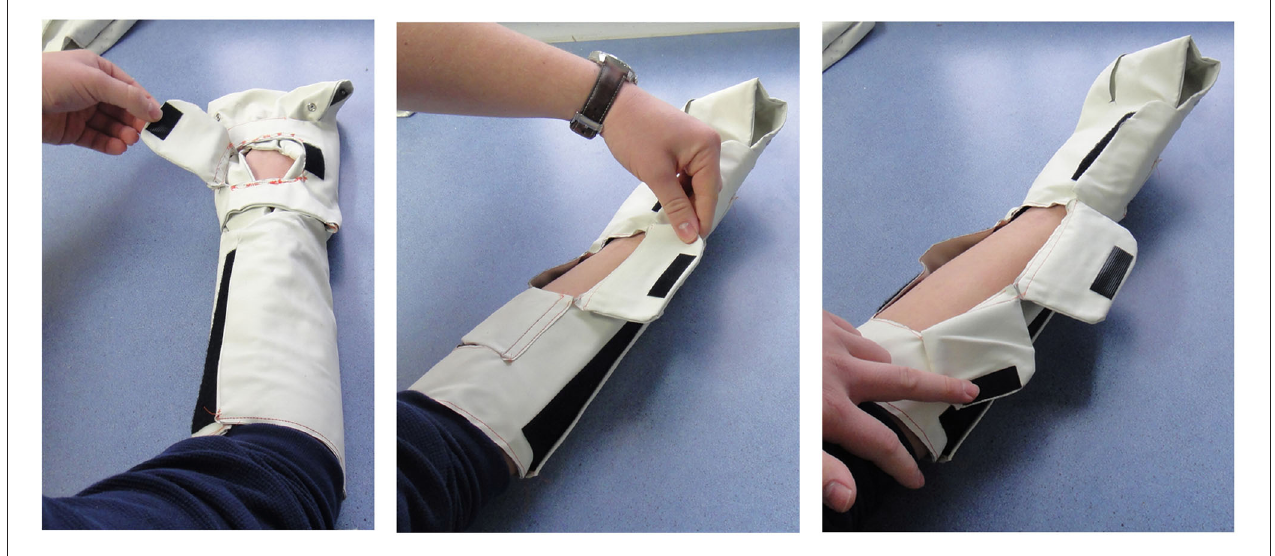
FIGURE 9 | Intravenous cannula site windows in the “Sketch Modeling” phase.